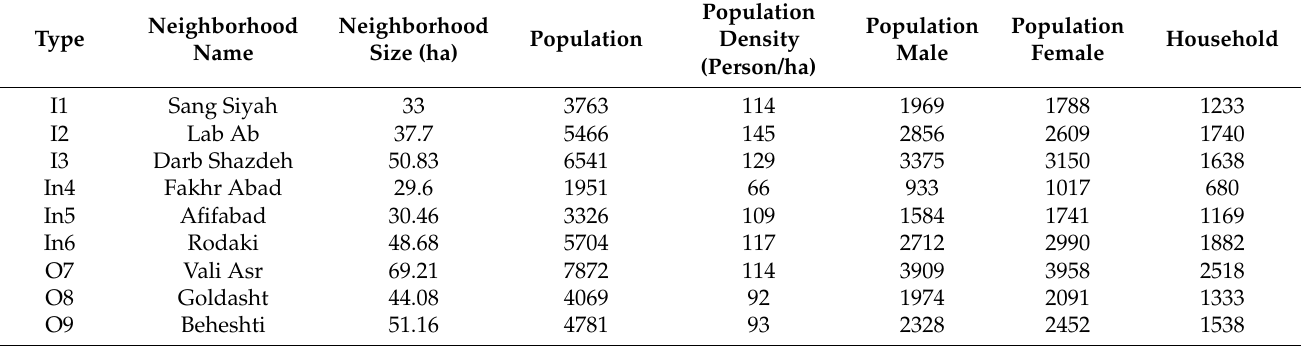
Figure 2. Layout patterns of the selected neighborhoods. Table 1. Some descriptive statistics related to the selected neighborhoods (source: master plan of Shiraz).